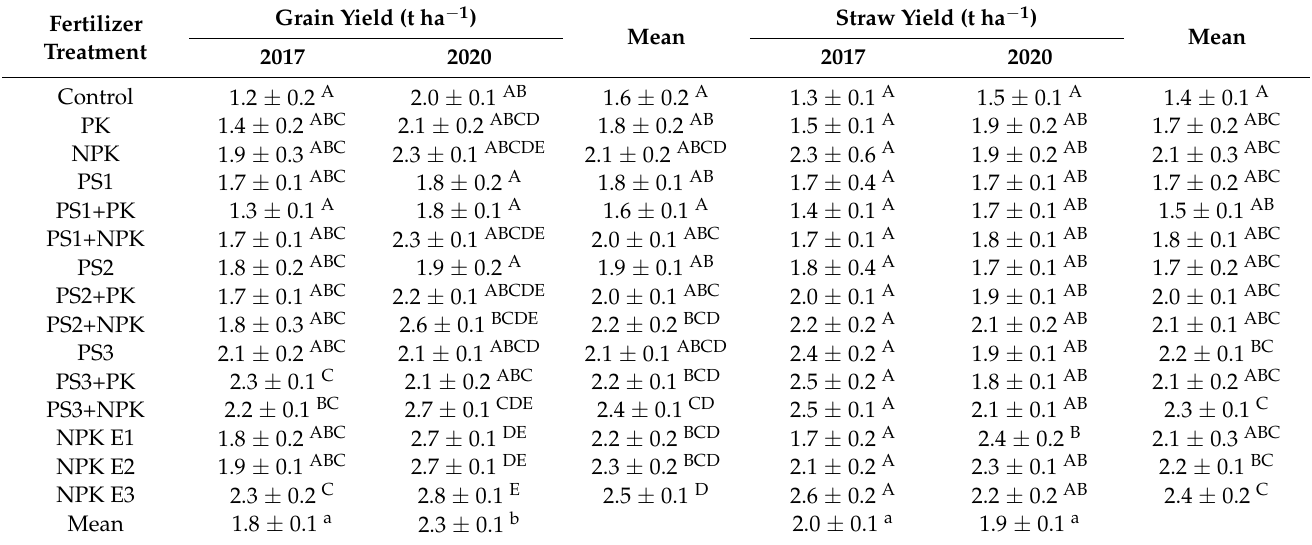
Table 7. The effect of the year (2017, 2020) and fertilizer treatment on FP grain and straw yield (t ha − 1 ) in Pernolec.